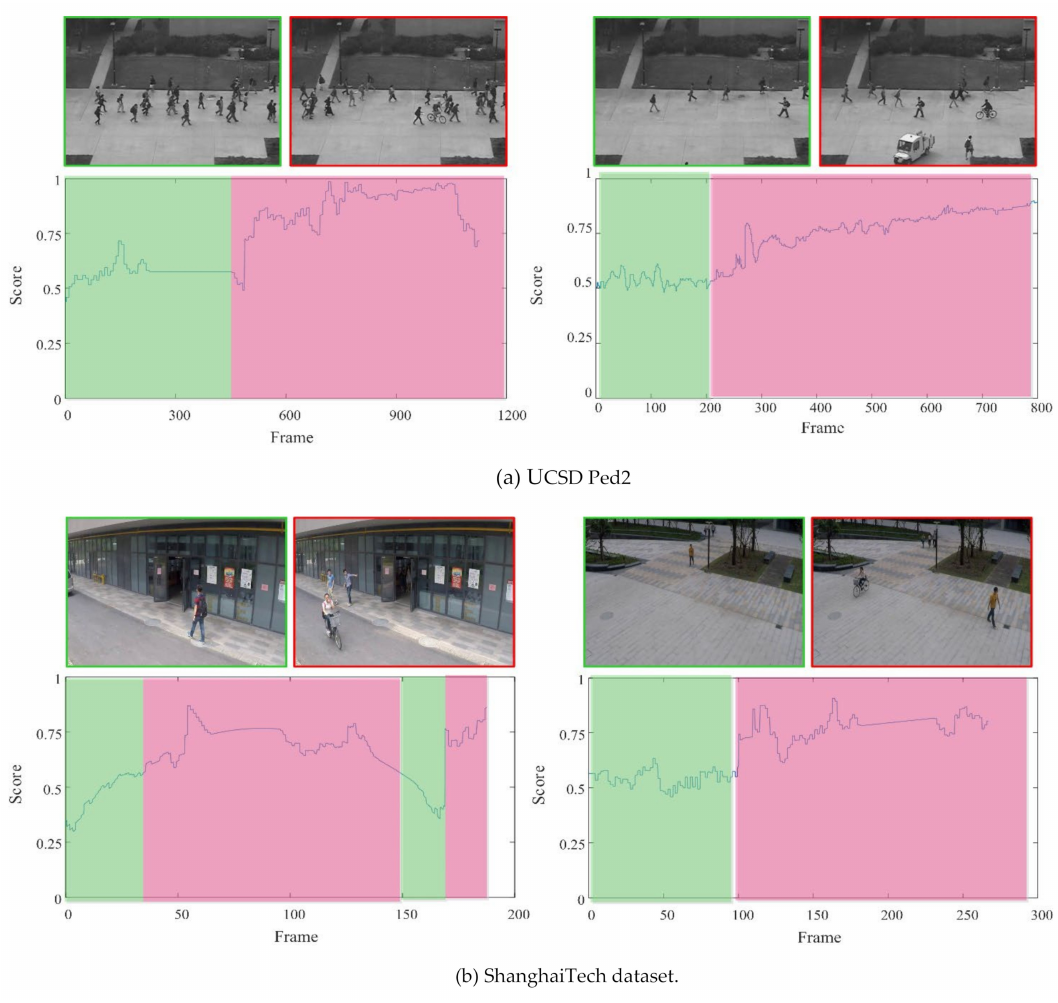
Figure 7. Visualization of the testing results.